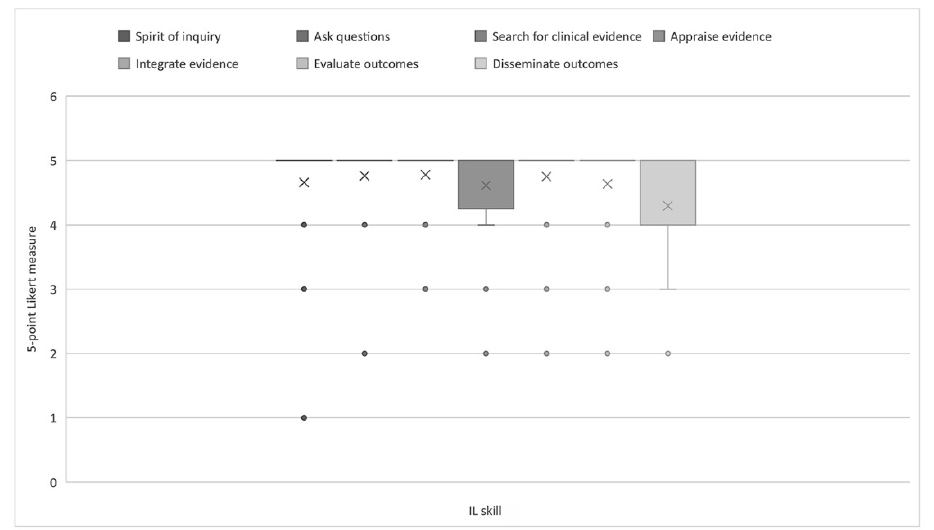
Figure 3 Nursing faculty ratings of the relevance of IL skills at the master’s level